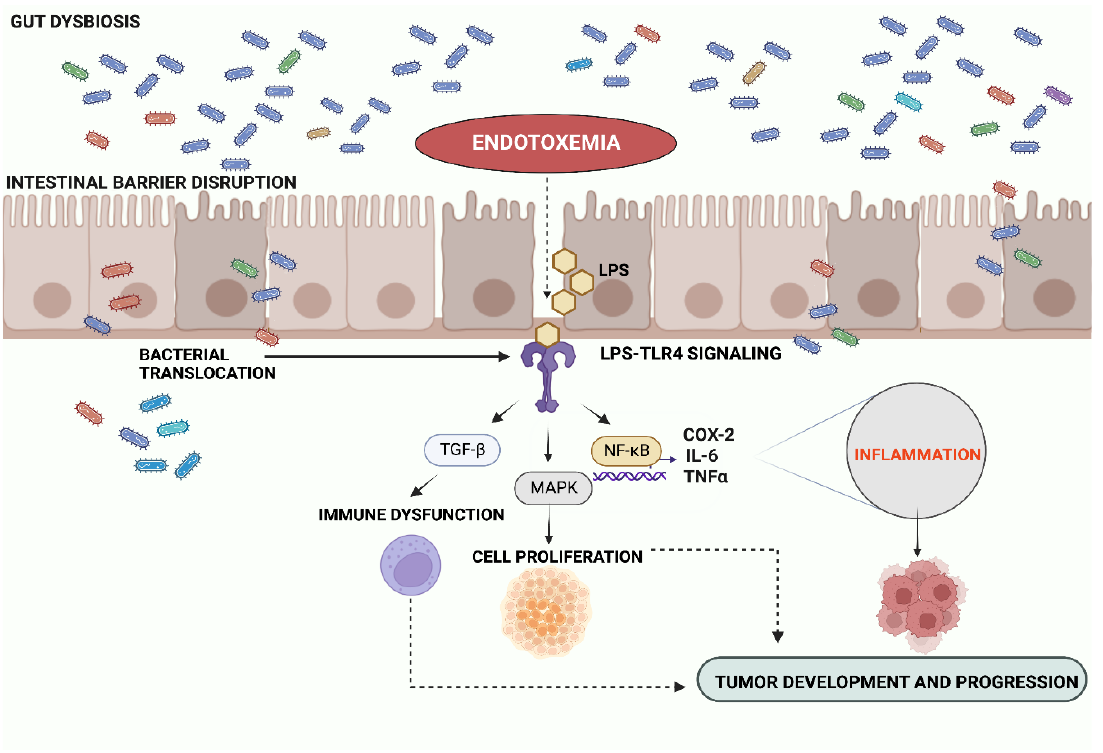
Figure 1. Pathways associated with endotoxemia and cancer risk. Gut dysbiosis and intestinal bar- rier impairment cause LPS translocation from gut lumen into the bloodstream, provoking endotox-